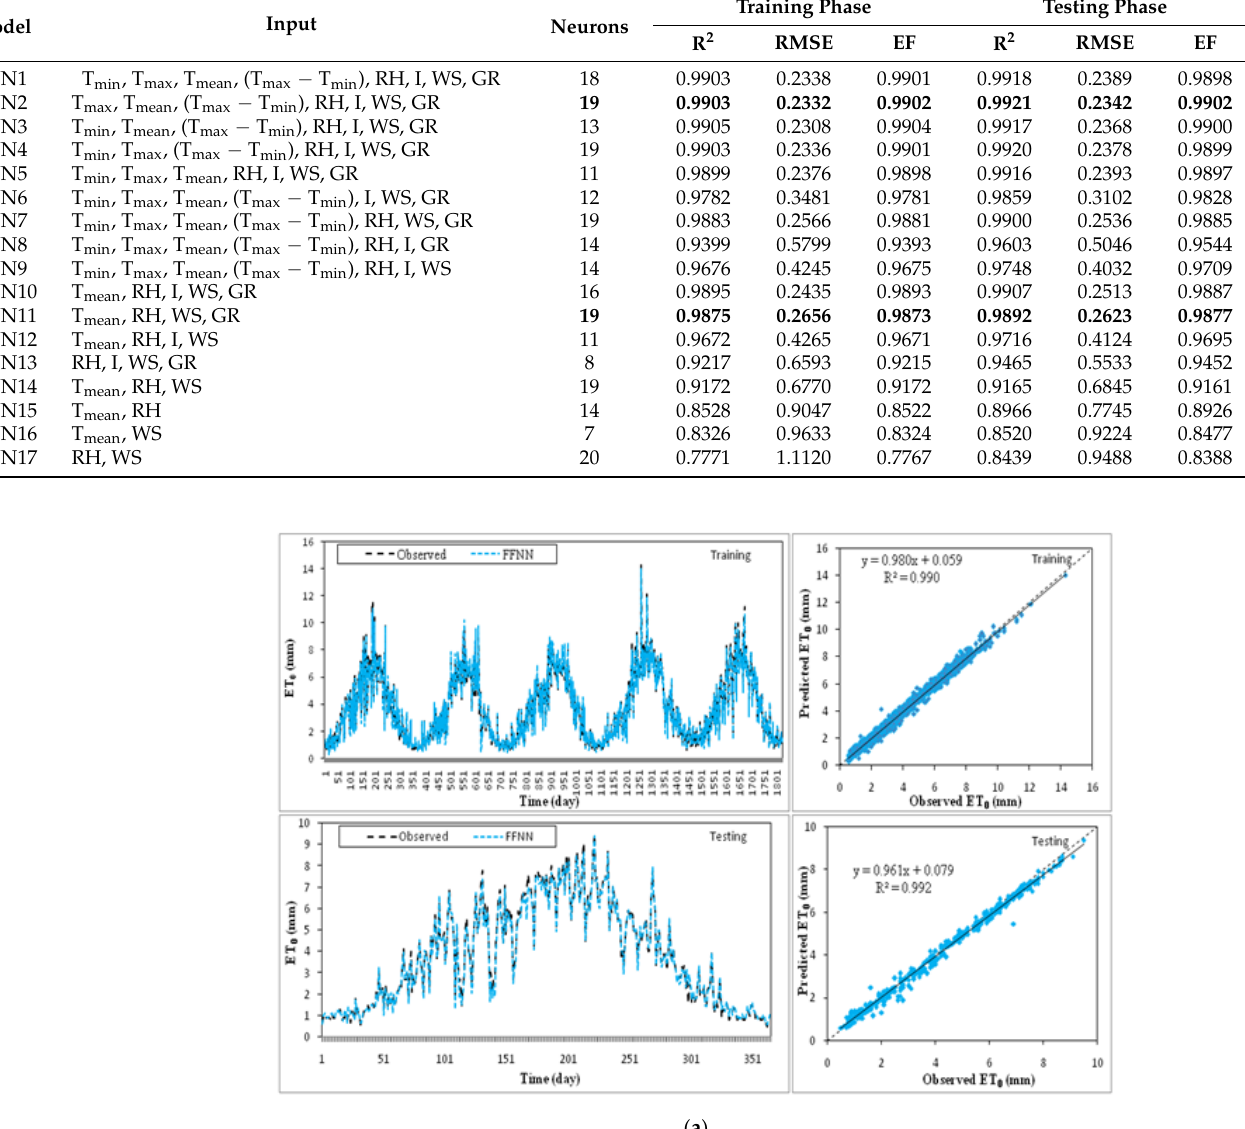
Table 4. Statistical criteria for an estimation of ET 0 using different input variables for FFNN. The bold part shows that this model is superior to others.